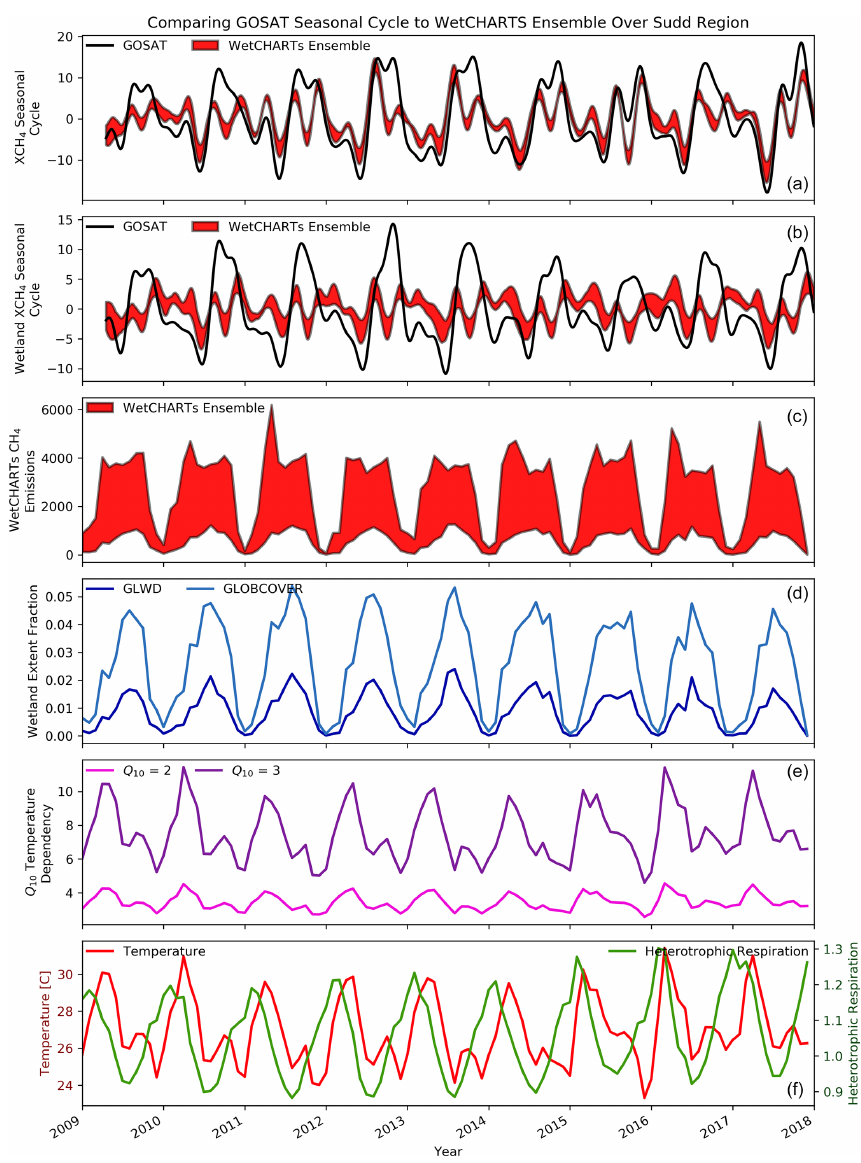
Figure 13. Time series over the Sudd wetland region showing (a) the GOSAT and WetCHARTs CH 4 ensemble seasonal cycle, (b) the wetland component of the above seasonal cycles once the modelled data with no wetland emissions have been subtracted, (c) the ensem- ble of WetCHARTs CH 4 emissions, (d) the wetland extent fractions, (e) the Q 10 temperature dependencies, and (f) the temperature and heterotrophic